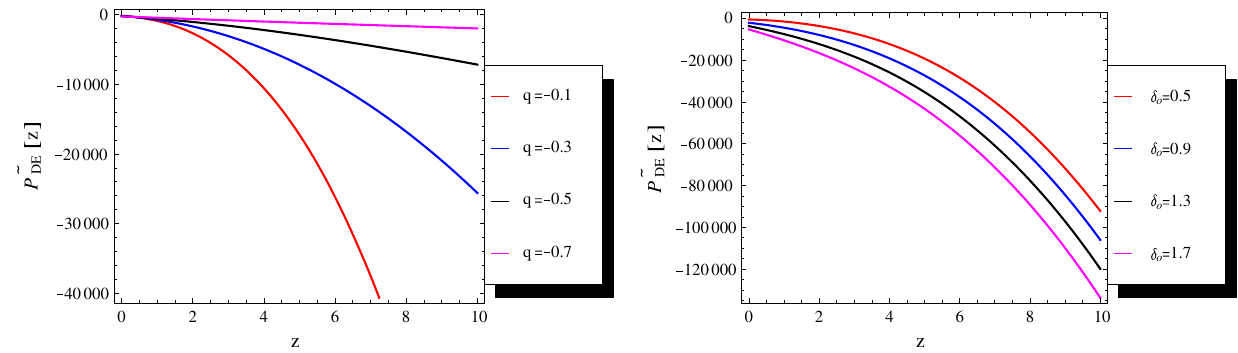
Fig. 2 The pressure ˜ P DE of Dark energy are plotted at left hand-side for variable deceleration parameter q and at right hand-side for variable bulk viscosity parameter δ o . The graphs are plotted for η = 1, h = 3 / 2, k = 3 / 4, e = 5 / 2, q = − 0 . 1 and δ o = 1 / 2 (panel in left